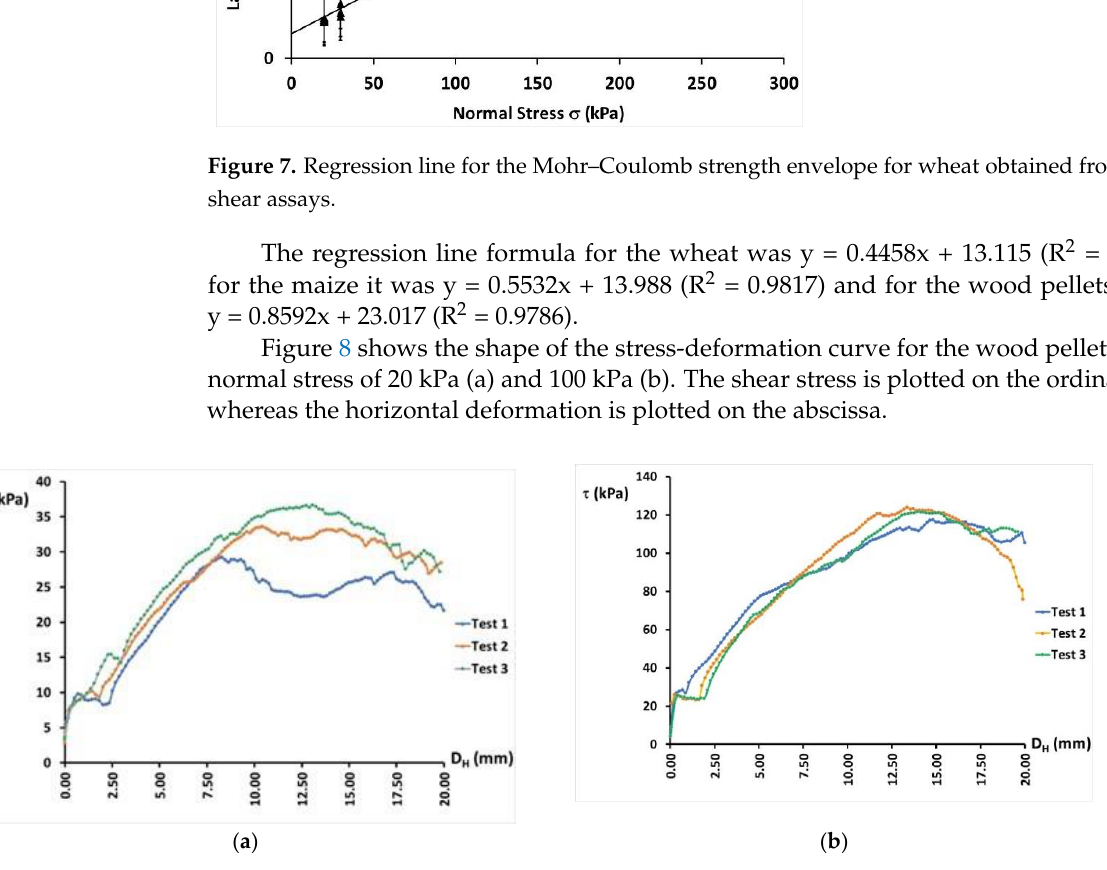
Figure 8. Stress-deformation curve for the wood pellets: ( a ) at a normal stress of 20 kPa; ( b ) at a normal stress of 100 kPa.